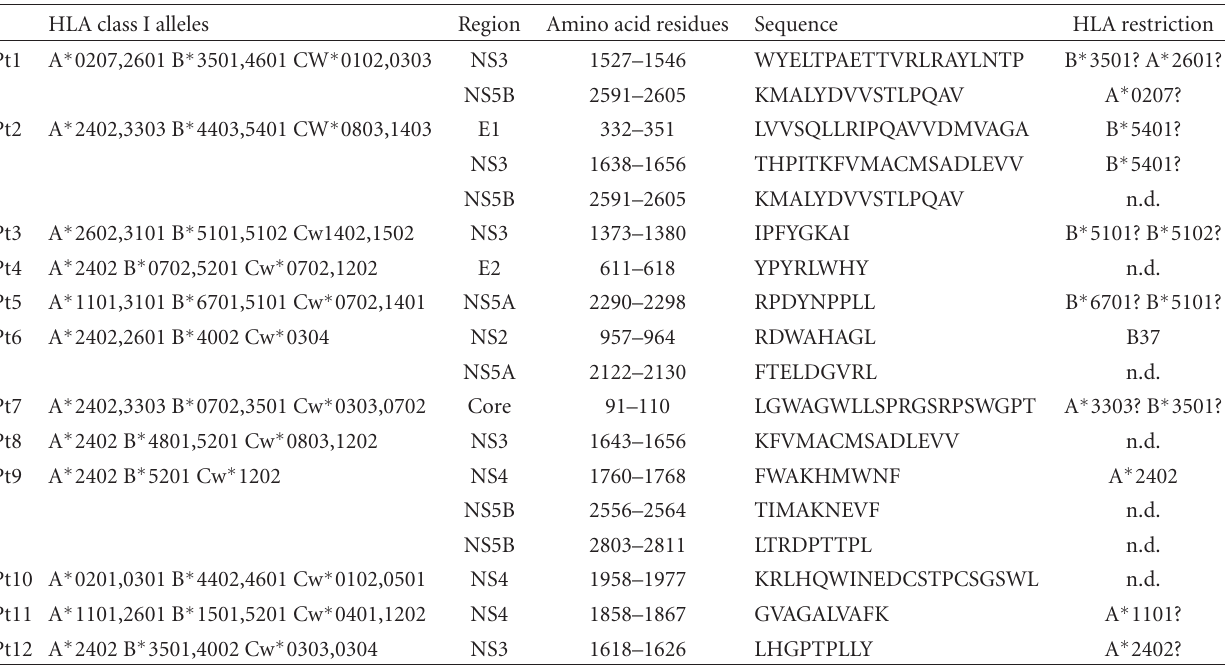
Table 1: CTL epitopes identified by using di ff erent